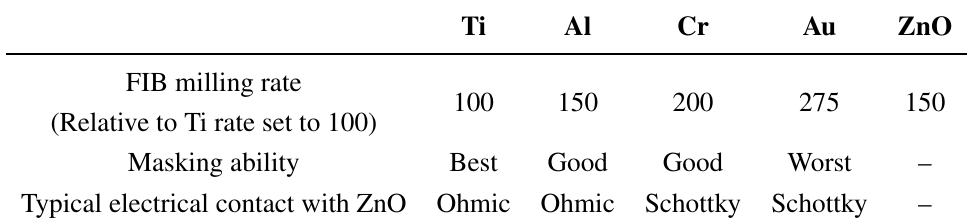
FIB milling rates, masking ability and the kind of electrical contact to the n-type ZnO [11] data for a selection of metals commonly used in microelectronics and MEMS technology. Ti Al Cr Au ZnO FIB milling rate 100 150 200 275 150 (Relative to Ti rate set to 100) Masking ability Best Good Good Worst – Typical electrical contact with ZnO Ohmic Ohmic Schottky Schottky